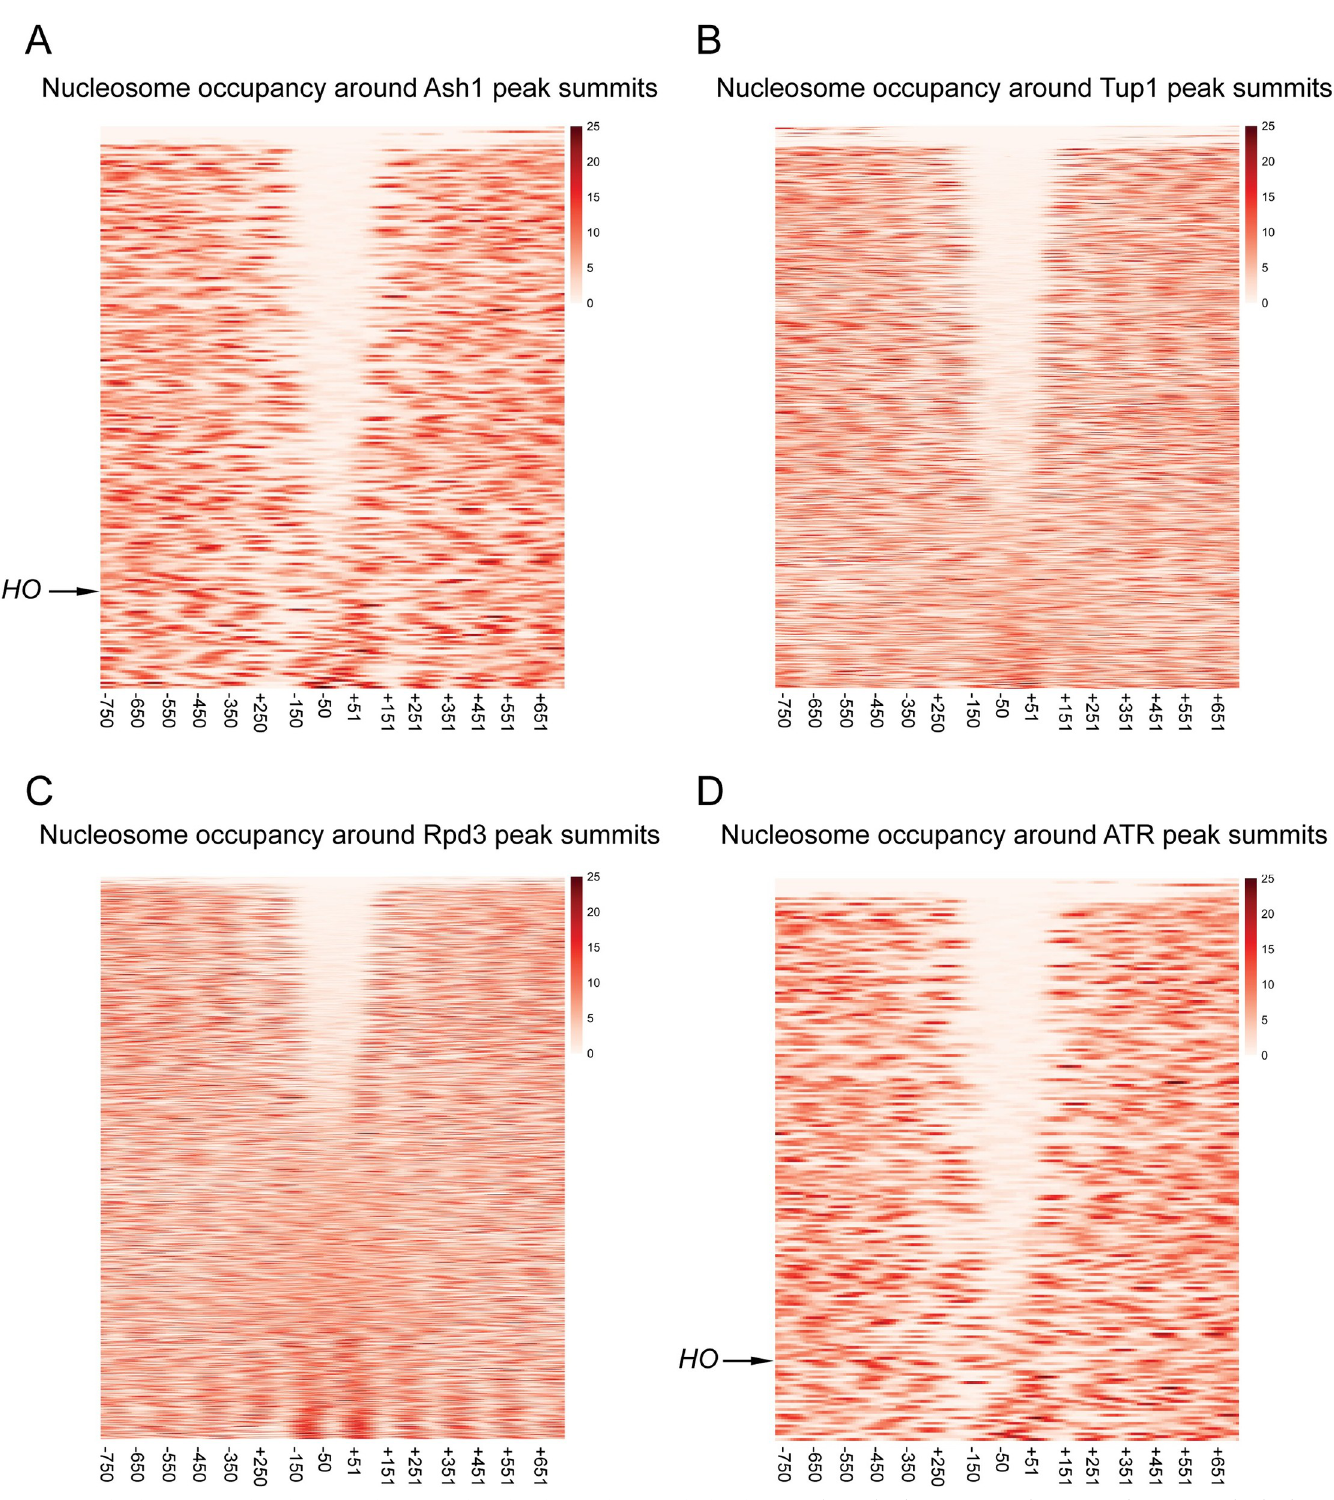
Fig 6. Sites of Ash1, Tup1, and Rpd3 co-enrichment are found within nucleosome depleted regions (NDRs). The MNase-Seq data was used to estimate the dyad position for each nucleosome, and this information was used to create a pileup of MNase-generated fragments, with each line representing a single gene. MNase-Seq heat maps are shown depicting the nucleosome occupancy surrounding the peaks for factor binding, displaying density from -750 to +750 nucleotides relative to the center of each peak, in bins of 20-bp. The color scale at the right indicates the level of nucleosome occupancy (fragments per million). (A) Each horizontal line depicts a